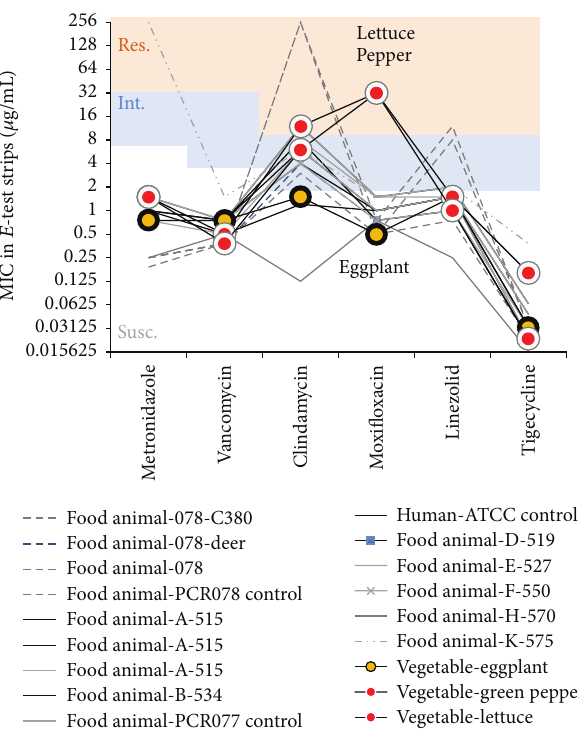
crobial resistance patterns of three vegetable isolates (Figure 1) and 15 animal derived isolates previously characterized in the USA [18, 37, 38]. The thick black lines/circles connect MIC values for each of the three vegetable isolates. Thin lines represent a collection of historical isolates and quality control duplicate testing. Res., resistance; Int., intermediate; Susc., susceptible highlighted standard or published